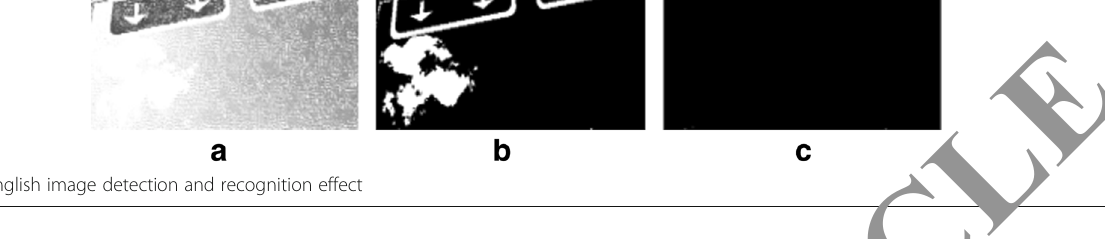
algorithm of this paper with the genetic neural network algorithm. The results obtained are shown in Table 1.